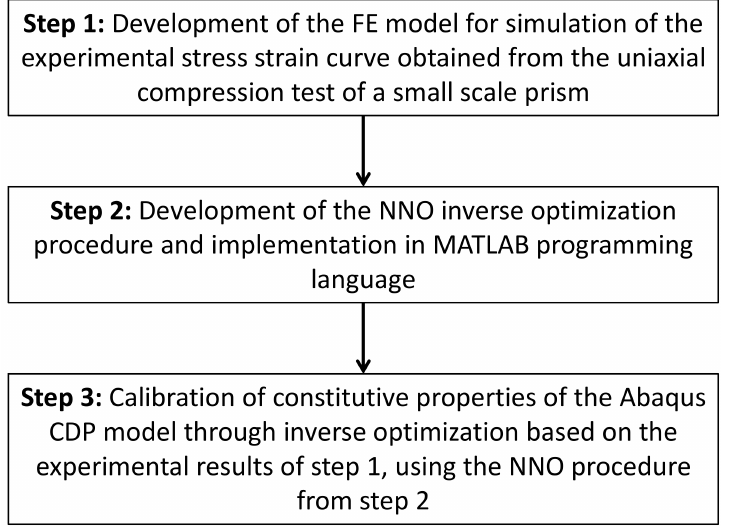
Figure 1. Flowchart of the steps implemented in the Section 3 of the present